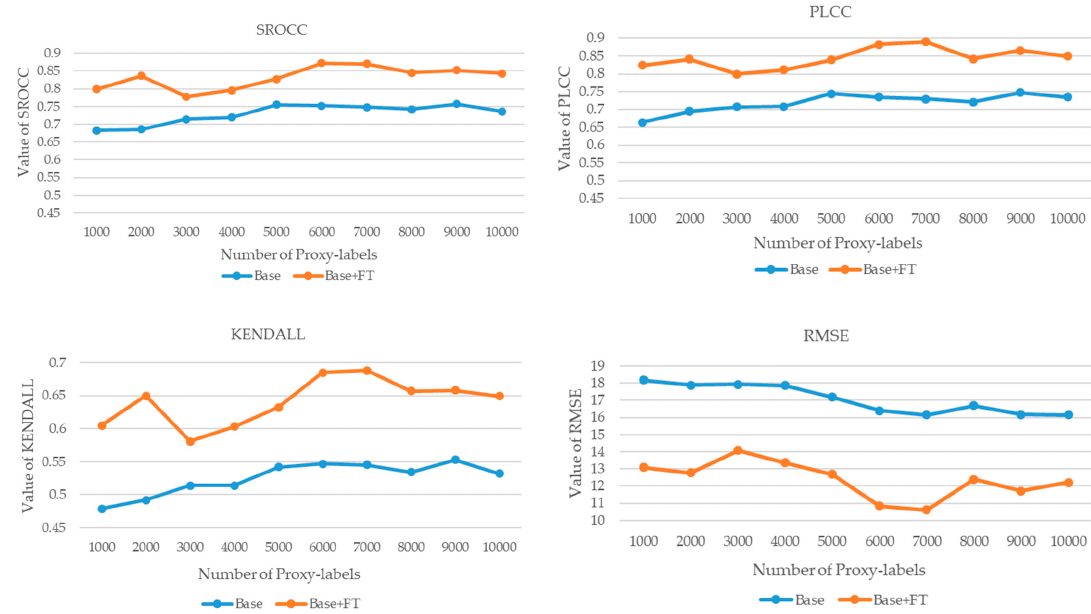
Figure 5. Comparing the performance of Base model and Base + FT model.